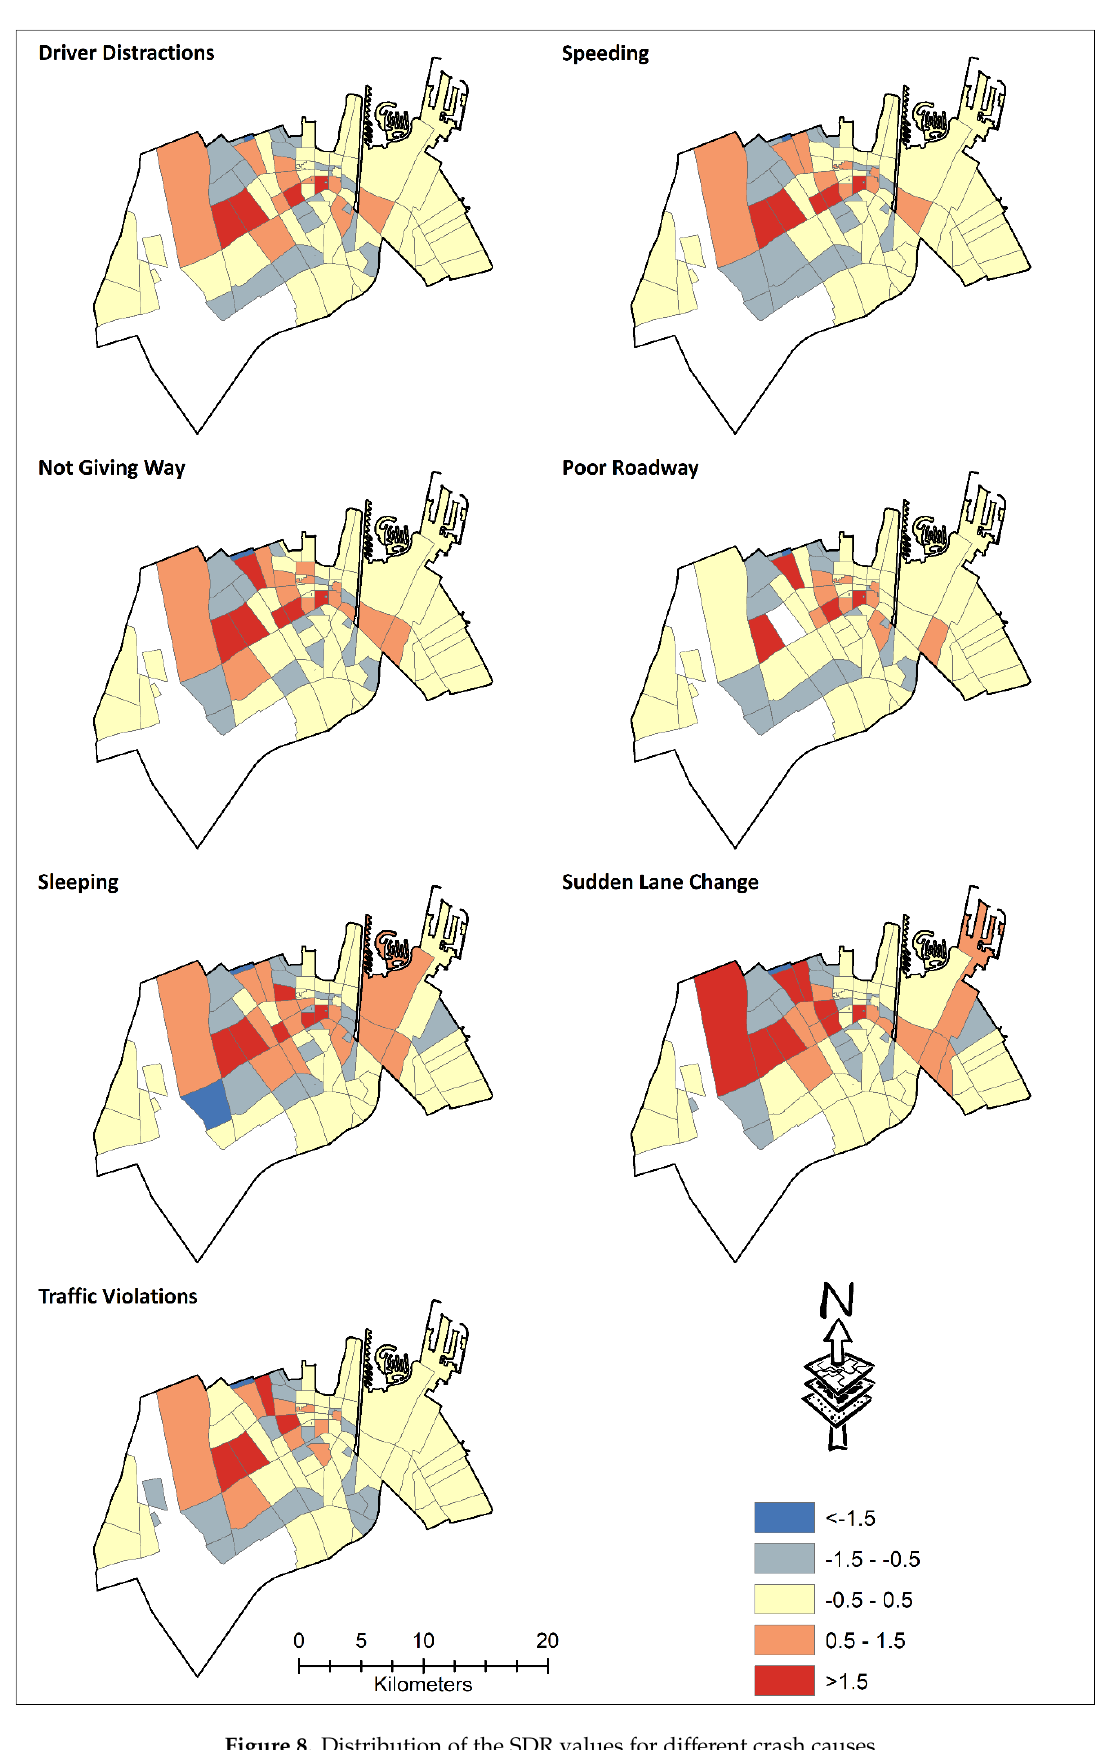
Figure 8. Distribution of the SDR values for different crash causes.